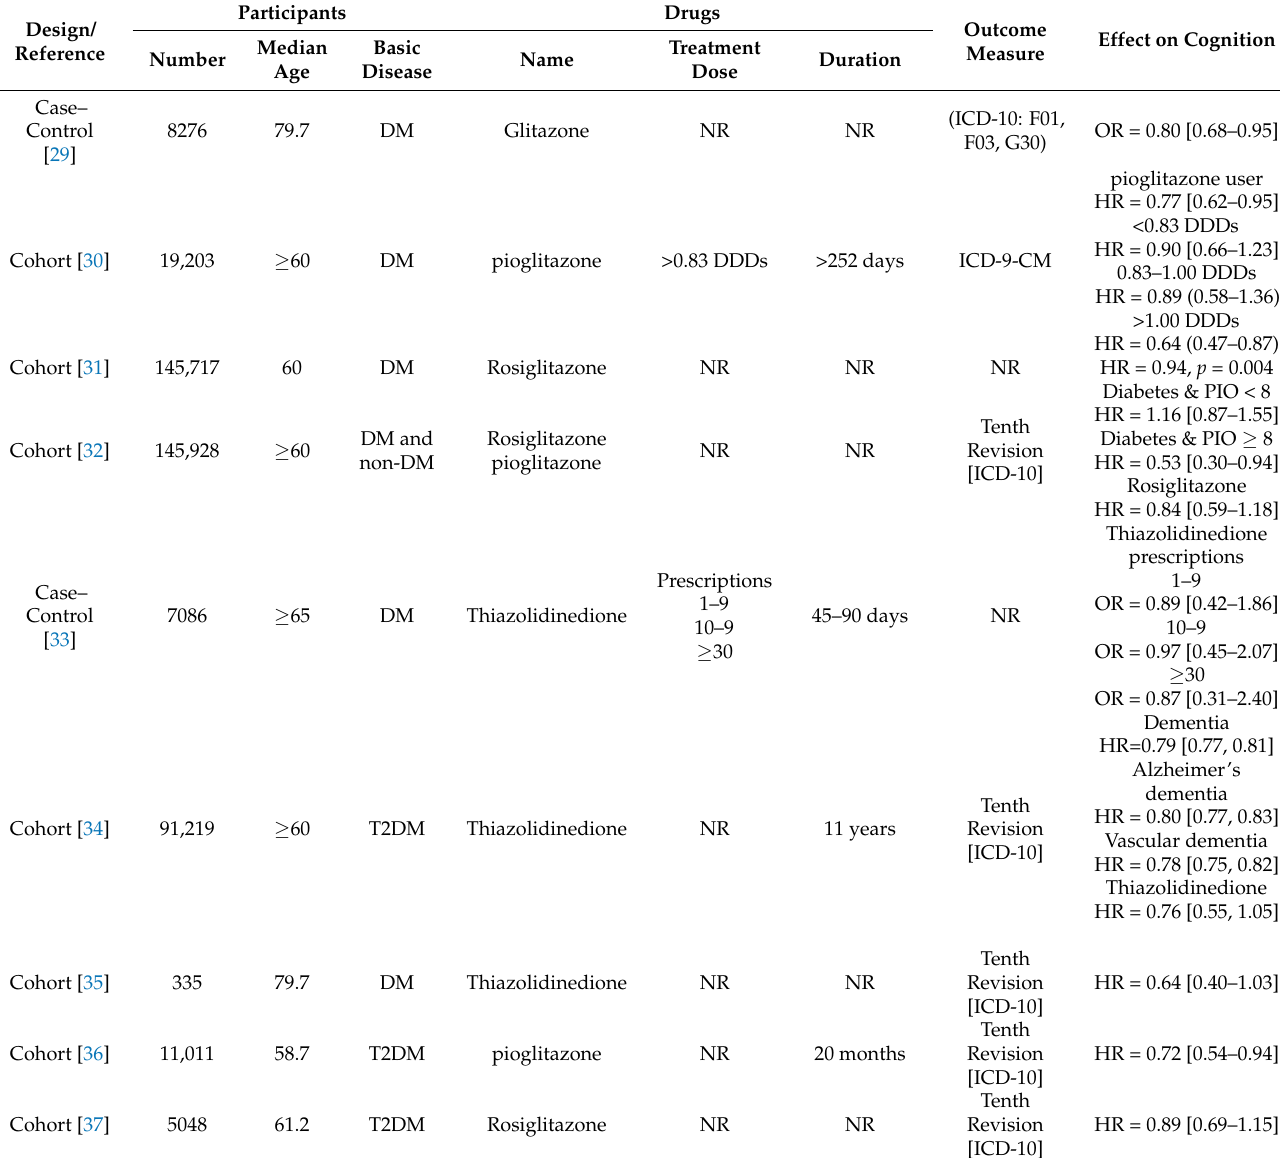
Table 1. Characteristics of included observational